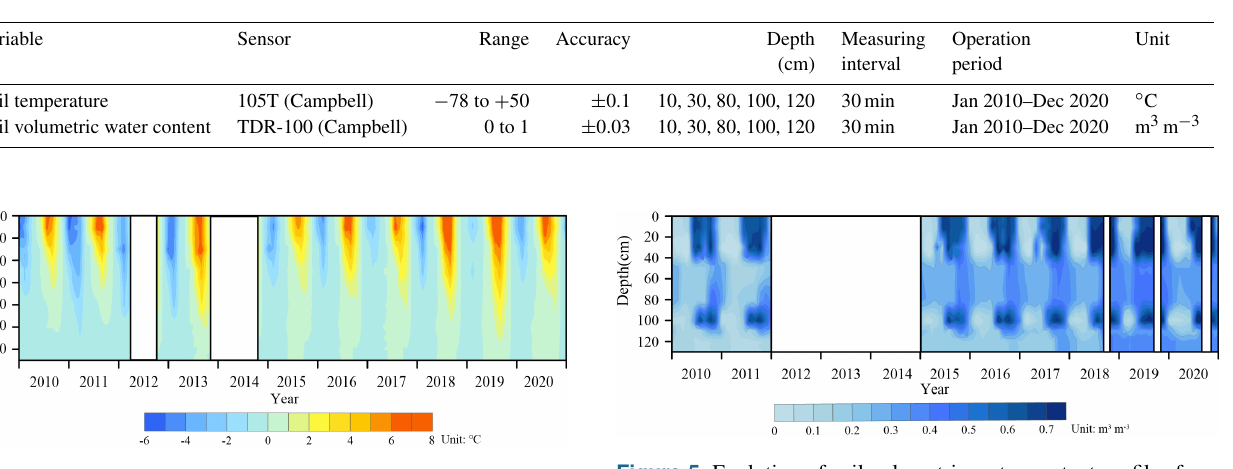
Figure 4. Active layer soil temperature profiles during 2010–2020 at the Mahan Mountain permafrost site. The blank gap stands for the missing data.